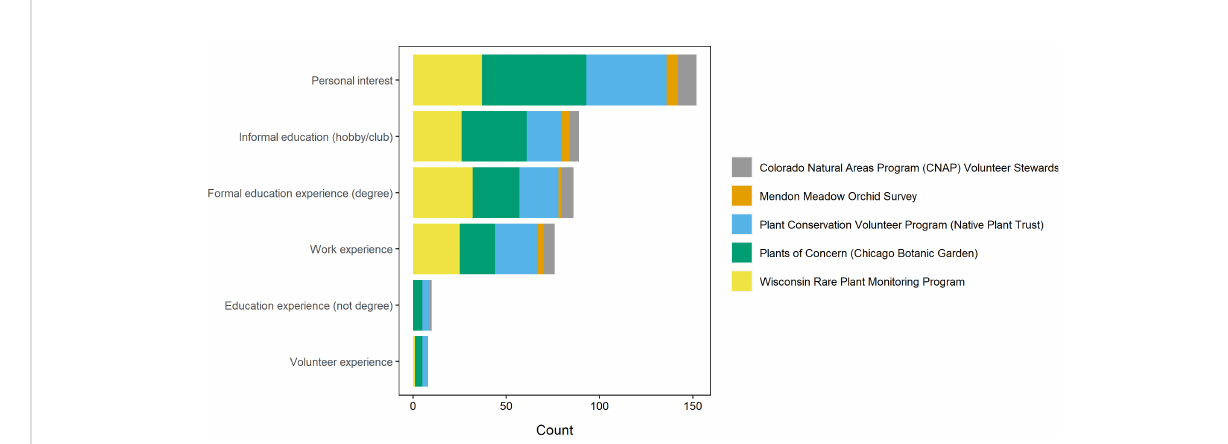
FIGURE 4 Prior experience held by project volunteers (n = 412). Color denotes community science